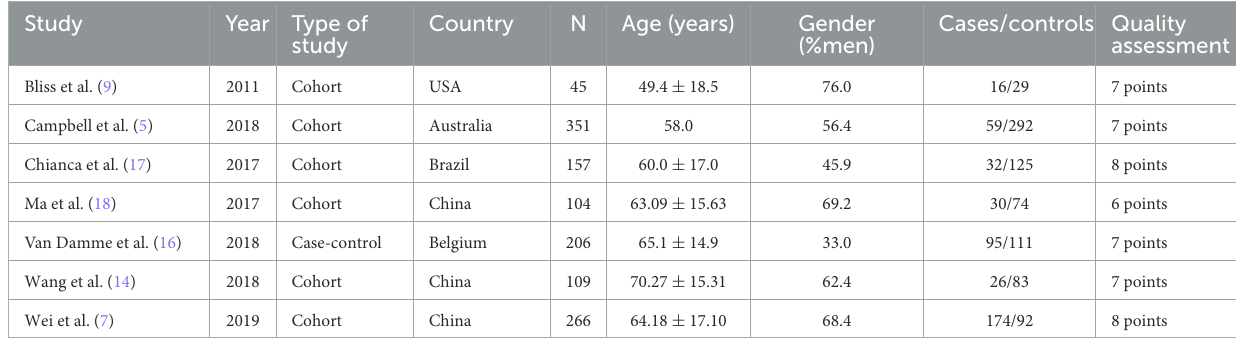
TABLE 1 Characteristics of studies included in the